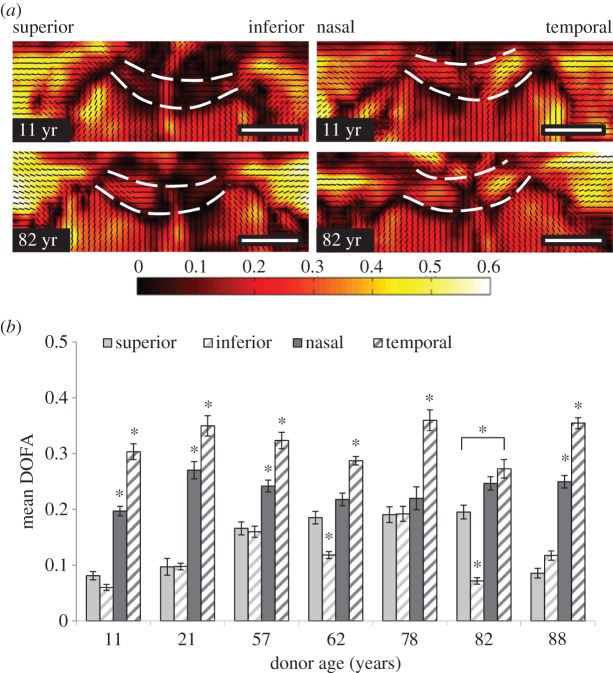
(a) SALS connective tissue DOFA (black: low alignment—white: higher alignment) and PFO (small black lines) fibre maps of longitudinal sections (superior–inferior and nasal–temporal orientation) of representative young (11 years) and elderly (82 years) human ONHs. Note the higher alignment (indicated by orange–yellow colour) in the temporal region in both aged ONHs. Anterior and posterior LC boundaries are denoted by the white dashed lines. Scale bars, 1000 µm. (b) Regional differences in DOFA (mean ± s.e.) within different aged (11, 21, 57, 62, 78, 82 and 88 years) LCs. DOFA was greatest in the temporal LC (*p < 0.001), and least in the superior and inferior regions within each ONH. Asterisk (*) denotes significant differences at p < 0.001 between a specific LC region and all other regions (unless indicated). Significant differences were determined using ANOVA with a Tukey post hoc test.